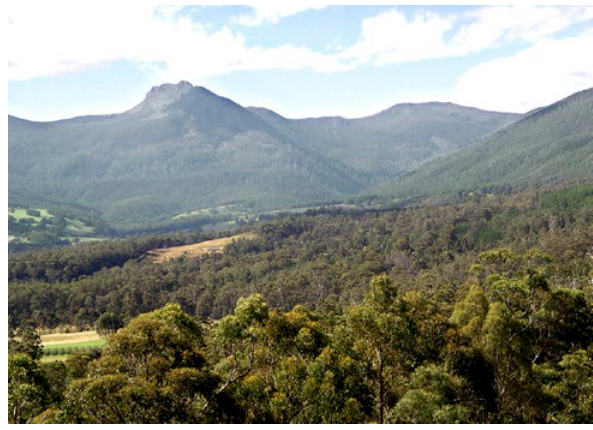
Figure 40. Think of the energy required if cavernous natural valleys were excavated by open cut mining methods (or by ancient quarry- ing methods before the advent of explosives and mechanical earth moving